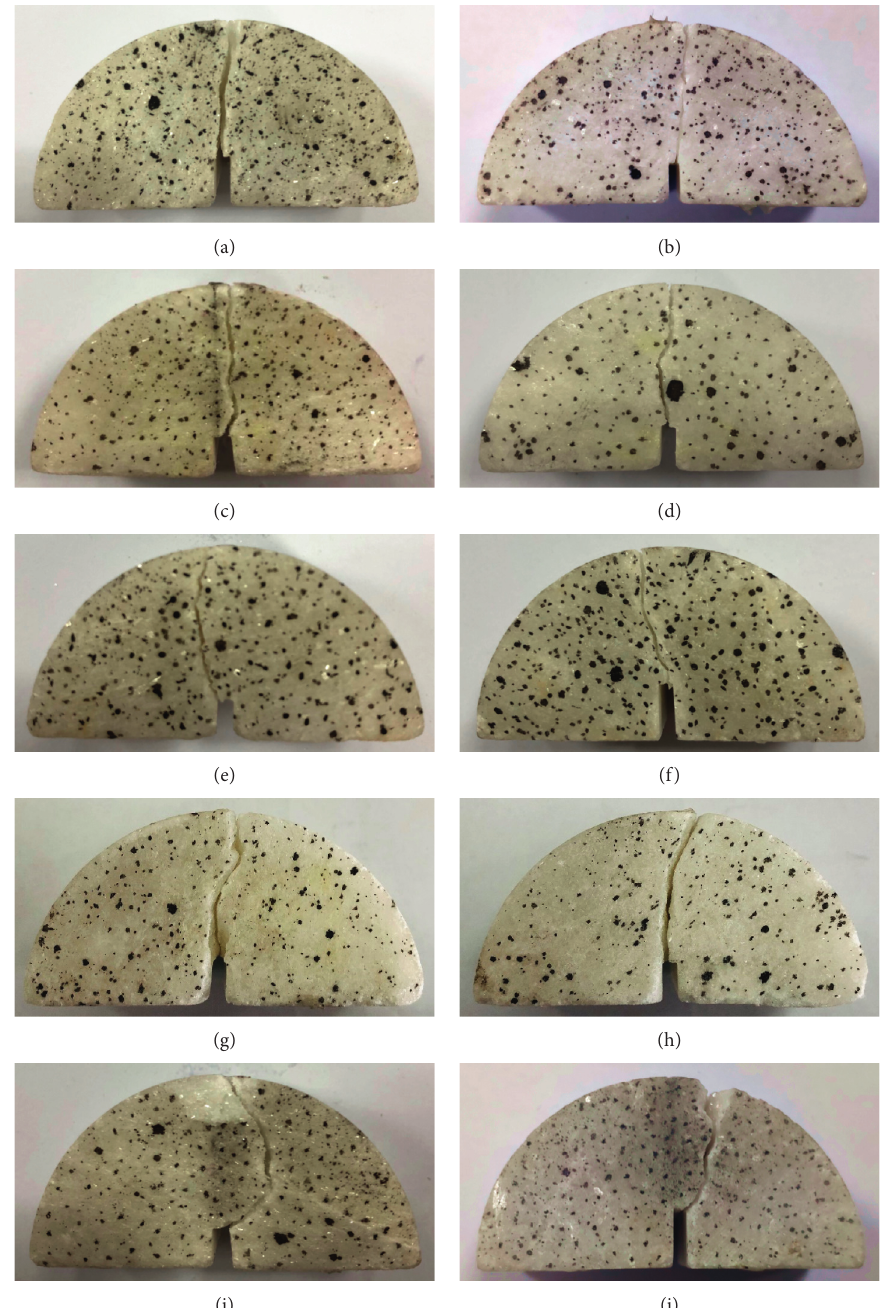
Figure 10: The typical failure patterns of NSCB specimens. (a) CJ0-Sa. (b) CJ0-Da. (c) CJ1-Sb. (d) CJ1-Dc. (e) CJ3-Sc. (f) CJ3-Db. (g) CJ4- Sb. (h) CJ4-Da. (i) CJ5-Sc. (j)